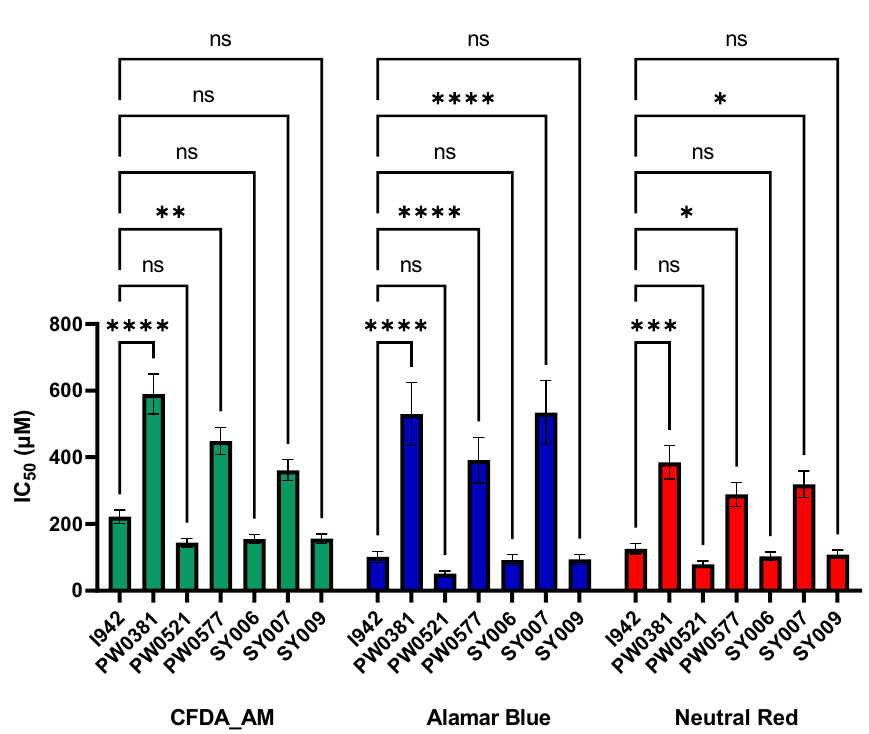
Figure 2. Cytotoxic effects of EPAC1 Activators in HUVECs. HUVECs were treated with a concentration range of I942 (3.9–500 µM) for 24 h, followed by incubation with a mixture of Alamar Blue and CFDA-AM dyes for 30 min in the dark. Fluorescence was then measured at 532/590 nm (for Alamar Blue) and at 485/535 nm (for CFDA-AM) ex/em wavelengths. Subsequently, cells were incubated with Neutral Red dye for 1 h in the dark, followed by cell solubilization and fluorescence reading at 532/645 nm ex/em wavelengths. Curves were fitted to the data collected in all three assays to obtain EC50 values, which are plotted here as a bar graph. Data are presented as means ± SEM (n =